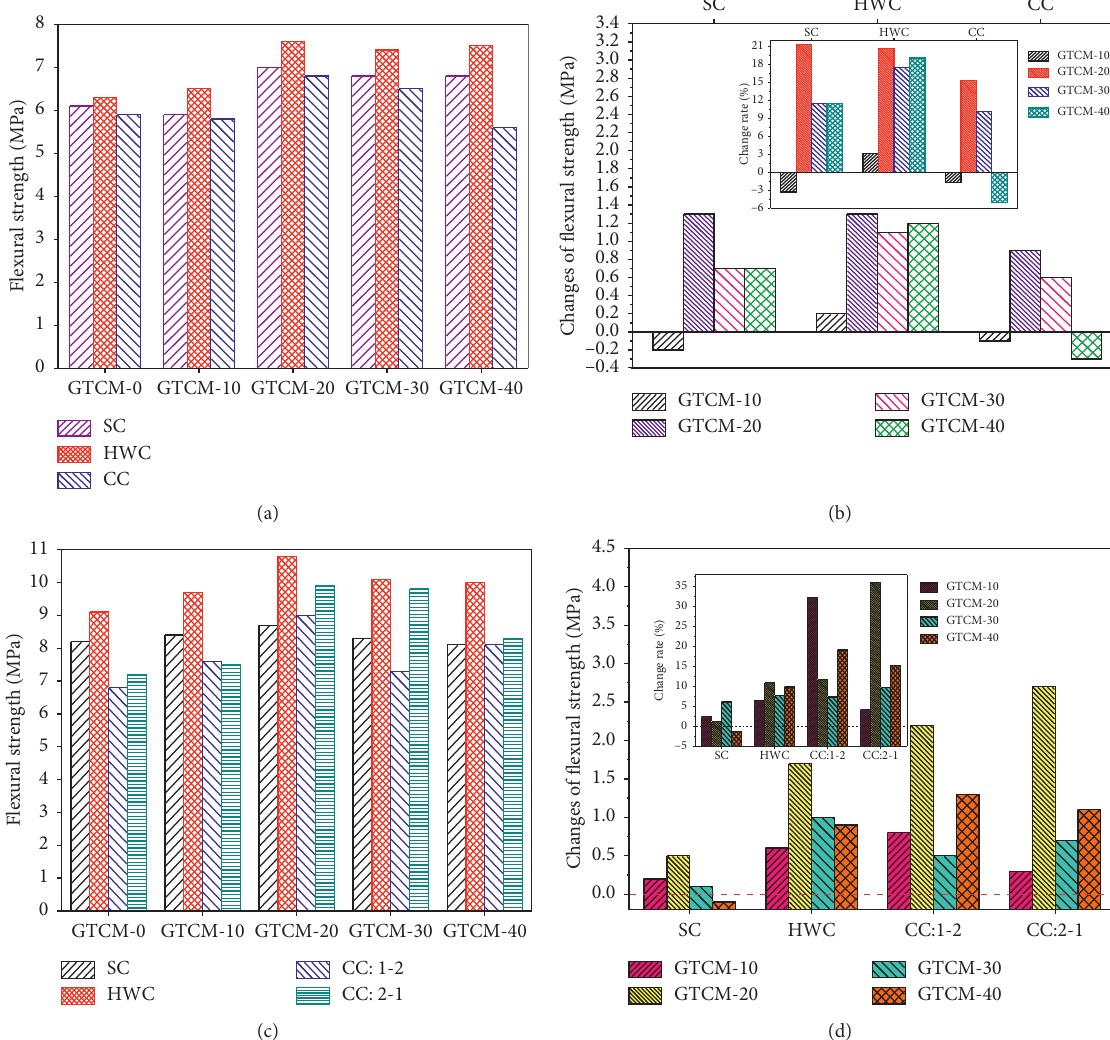
Figure 4: Flexural strength of GTCM under different cure methods: (a) 1 day; (b) changes of 1 day; (c) 3 days; (d) changes of 3